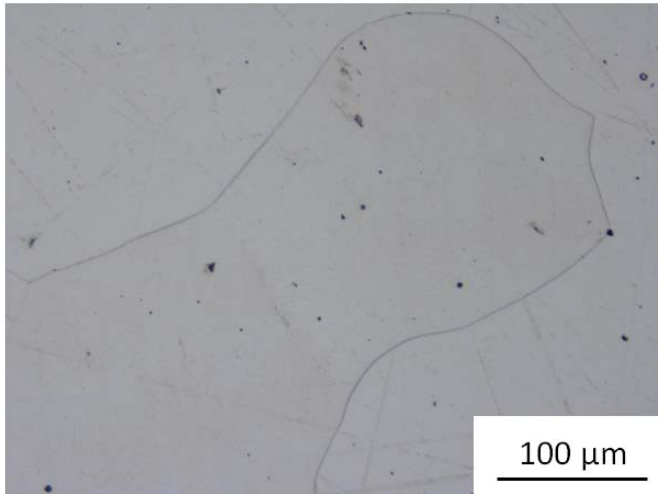
Figure 5. The microstructure of the MoNiCr alloy in its initial state: light micrograph.